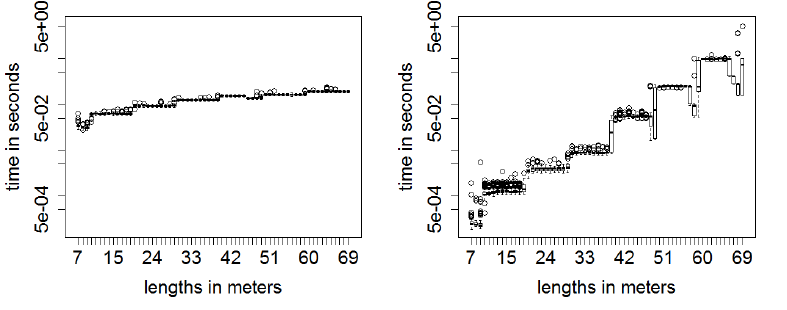
Figure 11. Time Comparison of: SucPP ( left ); and SimPP ( right